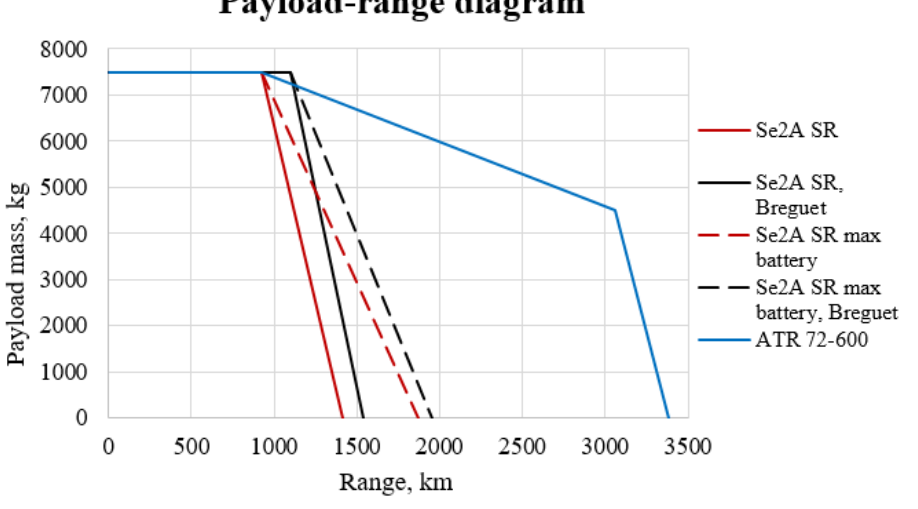
Figure 14. Payload-range diagrams for the SE 2 A SR and